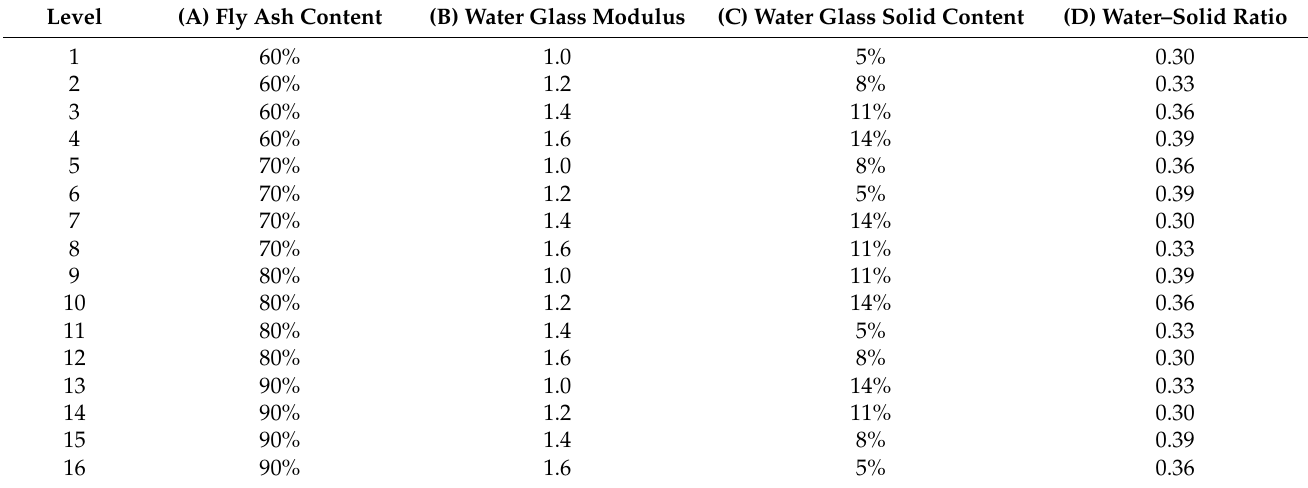
table with 5 factors and 4 levels is selected. The mix ratio design is shown in Table 5. Table 5. Test